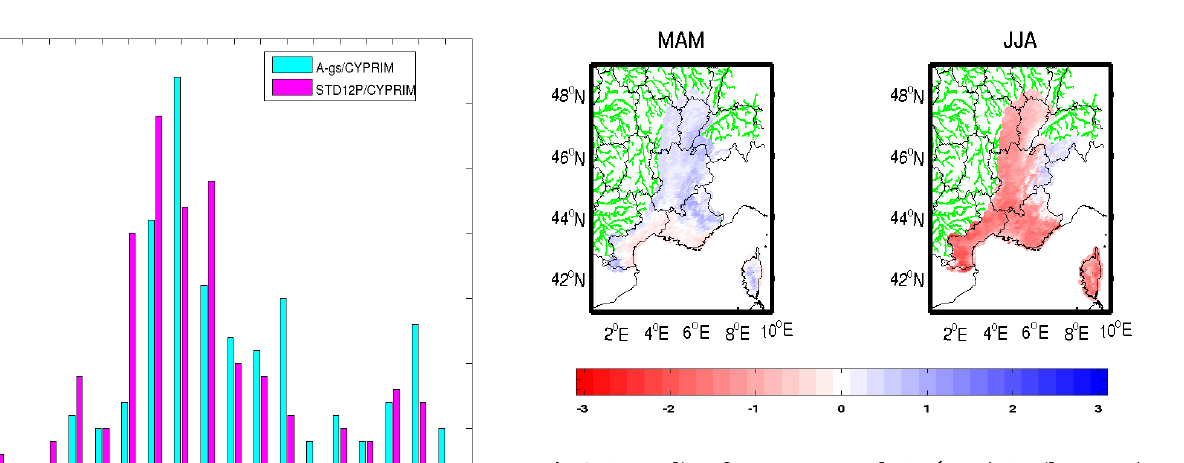
Fig. 6. Anomalies of average seasonal LAI (March-April-May and Figure 6: Anomalies of average seasonal LAI (March-April-May and June-July-August) 3 June-July-August) obtained with ISBA-A-gs. The anomalies are obtained with ISBA-A-gs. The anomalies are calculated by comparing two periods: 2069-4 calculated by comparing two periods: 2069–2099 vs. 2099 vs 1970-2000. 5